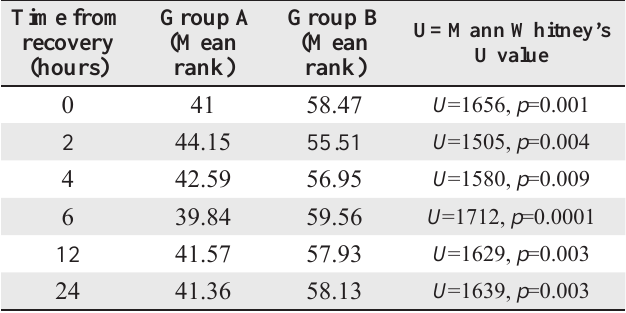
Table 2 : Visual analogue scale (VAS) scores for post-operative abdominal pain in two groups